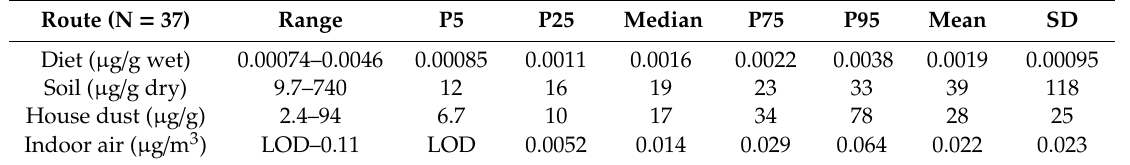
Table 3. Summary on Pb concentrations according to the exposure route.